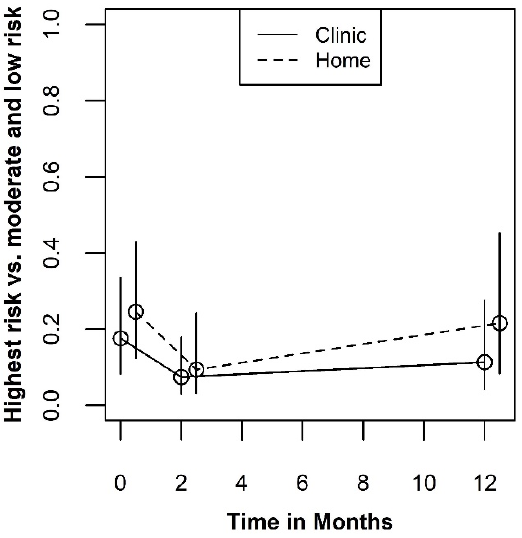
Figure 7. Plots for sexual behavior